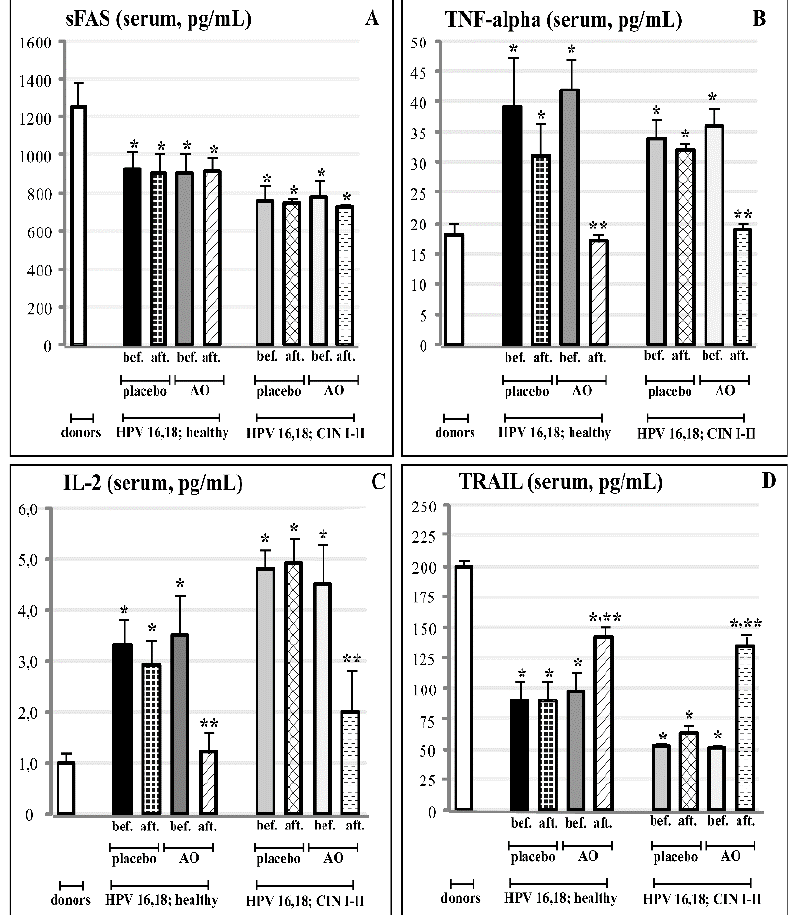
Figure 6. Effects of FM supplementation (AO) or placebo on serum content of the apoptosis ligands ( A —sFAS; B —TNF-alpha; C —IL-2; D —TRAIL) in groups of practically healthy HPV16- and HPV18-infected females (n = 152), and in groups of HPV16- and HPV18-infected females with pre-cancerous cervical lesions (CIN I and CIN II) (n = 98). * p < 0.05 vs. donors; ** p < 0.05 vs. before treatment.